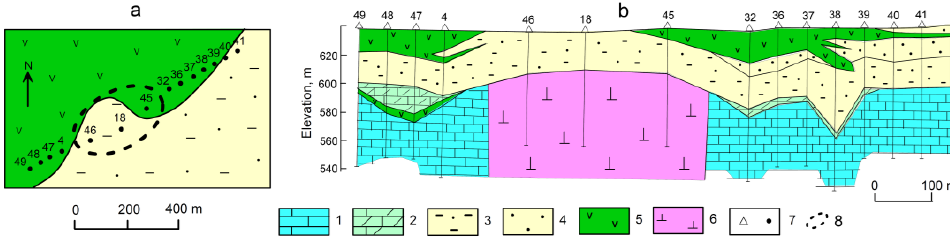
Figure 2. Features of the structure of dolerite sills and the top edge of hosting carbonate rocks near the kimberlite pipe Vostok in the Alakit-Markha field of Yakuta. ( a ) — plan, the location of wells, the kimberlite pipe Vostok in the Alakit-Markha field of Yakuta. ( a )—plan, the location of wells, ( b ) — section along wells 49 – 41. 1 — carbonate rocks, 2 — fractured carbonate rocks, 3 — sandstones ( b )—section along wells 49–41. 1—carbonate rocks, 2—fractured carbonate rocks, 3—sandstones and siltstones, 4 — sands, 5 — dolerites, 6 — kimberlites, 7 — well and its number, 8 — contour of the pipe.